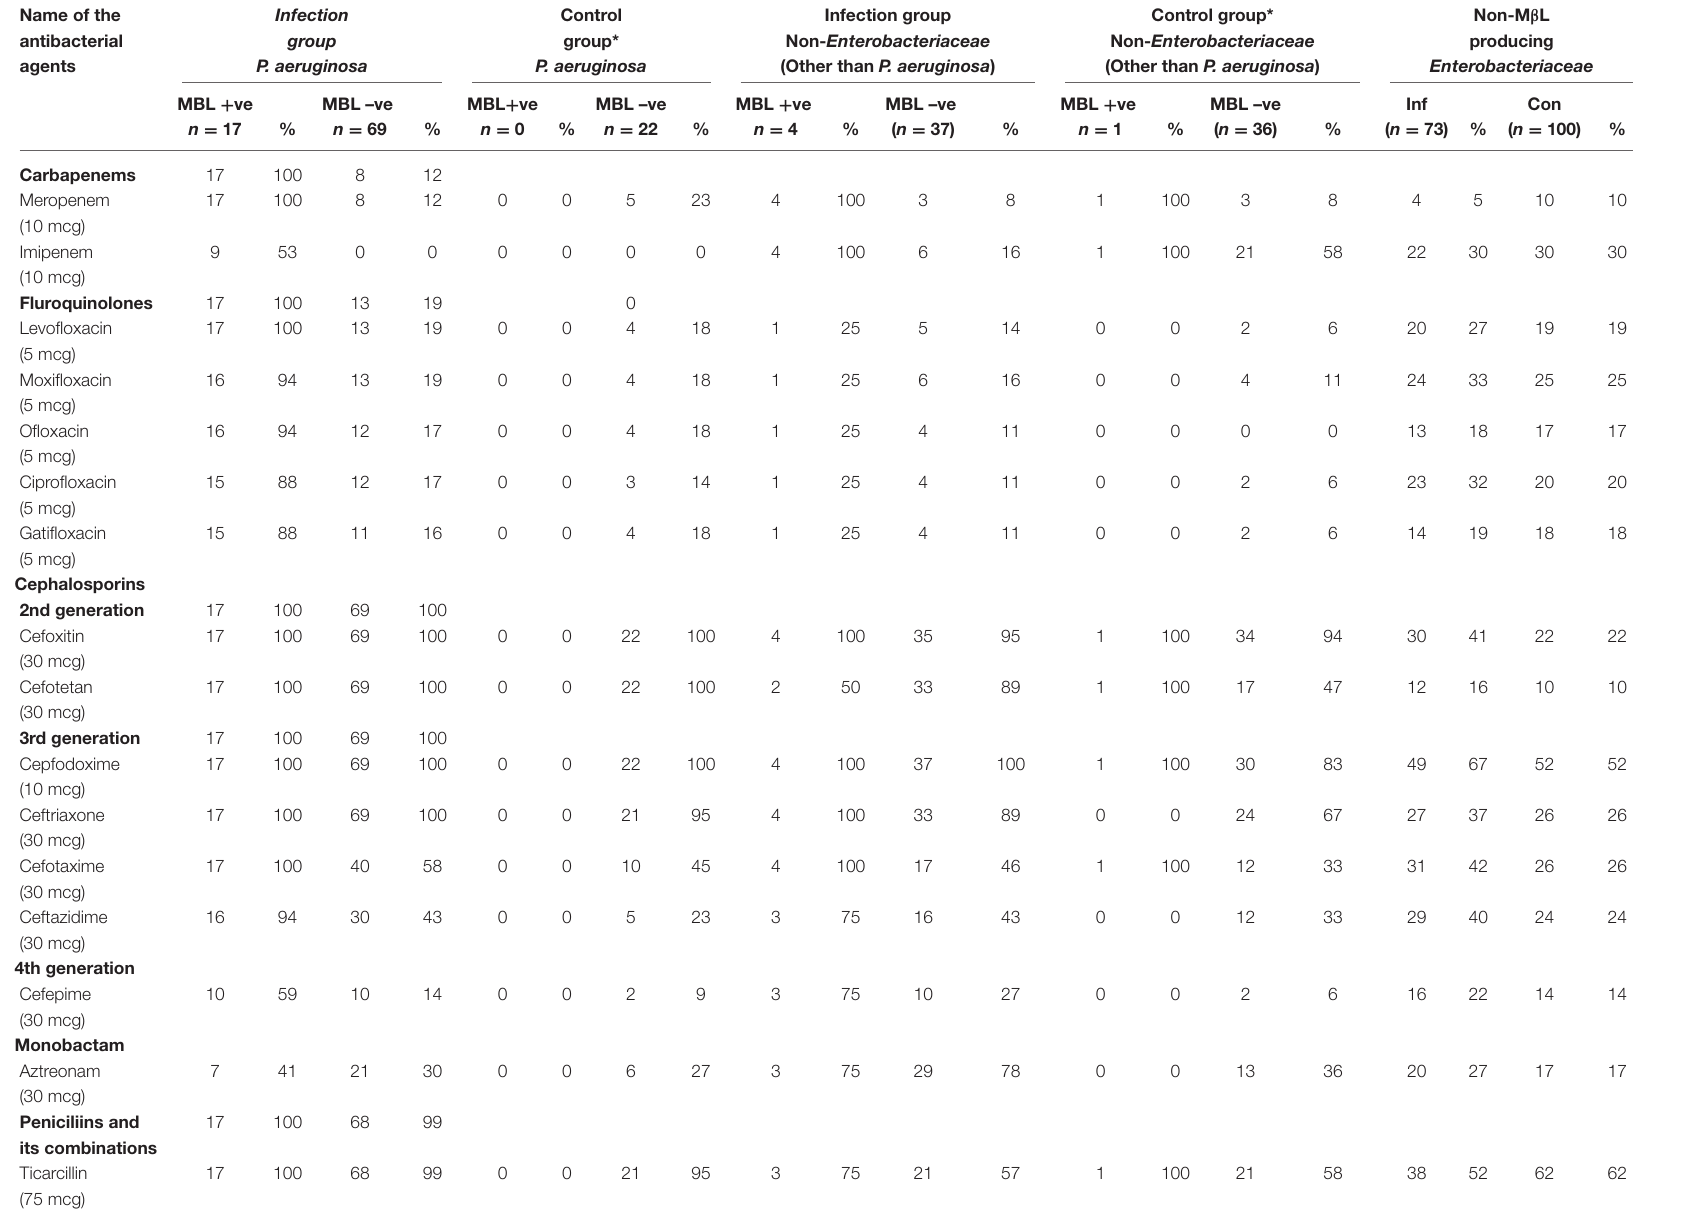
TABLE 4 | Antibiotic resistant profile of MBL vs non-MBL producing P.aeruginosa and other Enterobacteriaceae vs non- Enterobacteriaceae . Name of